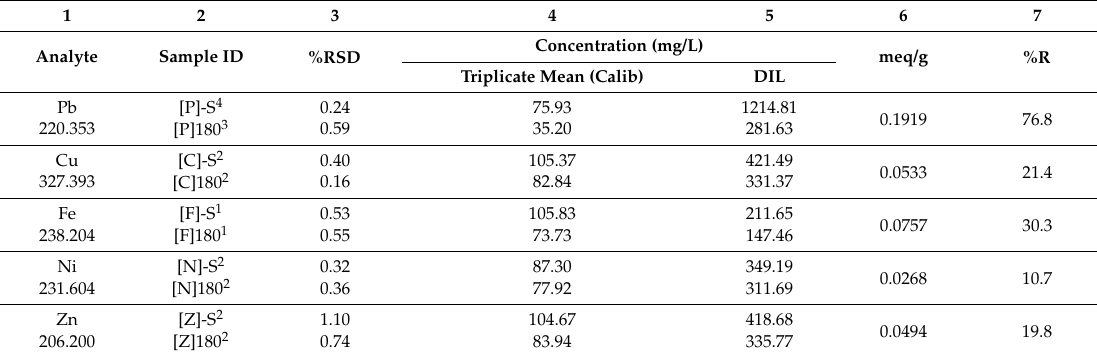
Table 1. ICP-AES HMI results of the single-component systems.